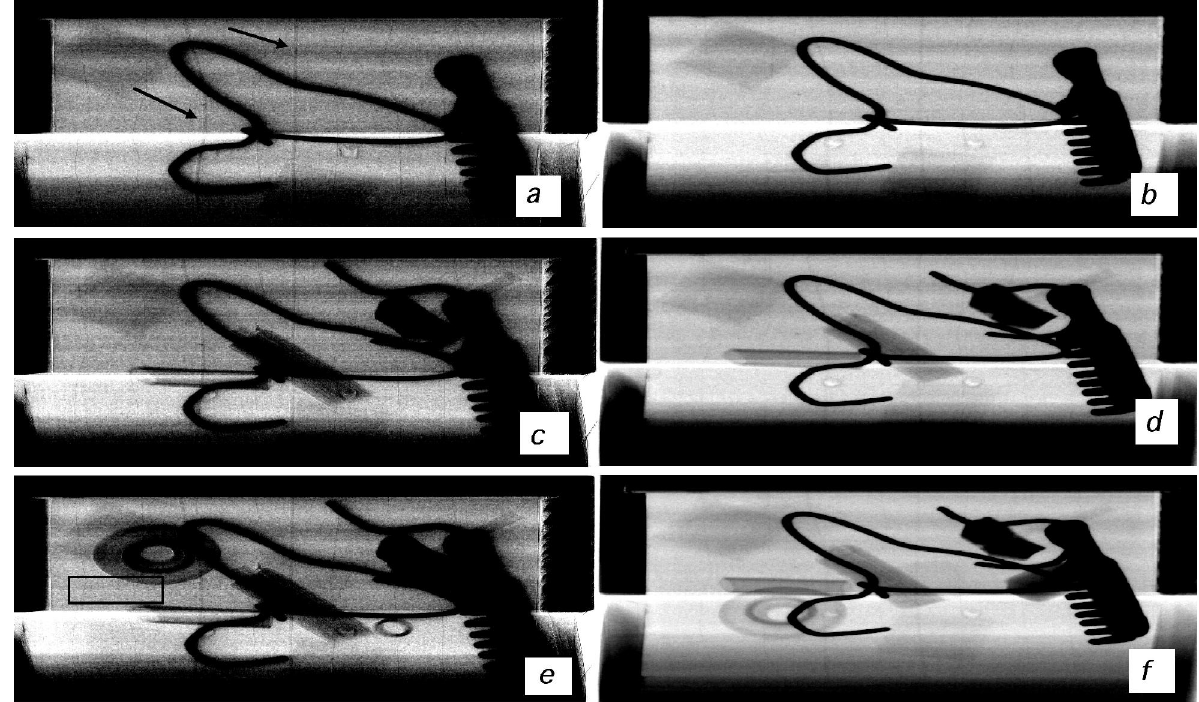
Figure 7. XPCi (left-hand side) vs. conventional (right-hand side) images of one of the custom test objects. The level of clutter is increased going from top to bottom. Arrows in ( a ) highlight the presence of two of the “thicker” (300 µm) wires: the position of these and other wires is the same for all other images (see text). The box in ( e ) highlights the area expanded in Figure 8(a); exactly the same area was extracted from ( f ) to obtain the image shown in Figure 8(b).